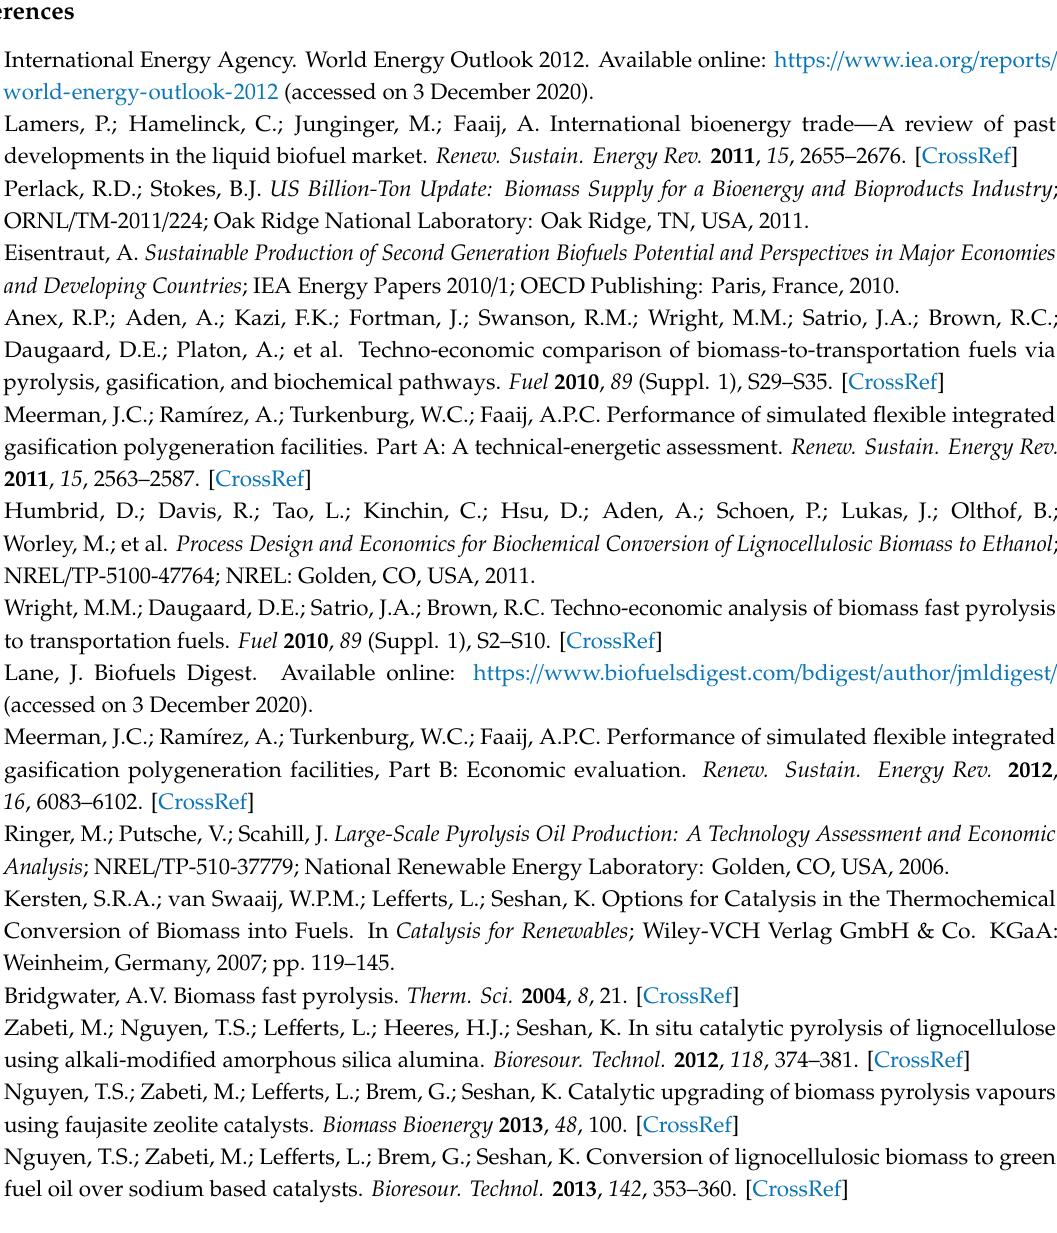
Figure S1: Temperature-programmed oxidation of coke formed on the Cs / ASA catalyst, Table S1: Output data from pyrolysis reactions used for process simulations, Table S2: Data and assumptions for separation model, Table S3: Key stream names and descriptions for the streams reported in Tables S4–S7, Table S4: Stream flow data for pyrolysis using Cs / ASA catalyst, Table S5: Stream flow data for pyrolysis using Na-Alumina catalyst, Table S6: Stream flow data for pyrolysis using HY-Zeolite catalyst, Table S7: Stream flow data for thermal pyrolysis, Table S8: Data values for Figure 4 in the